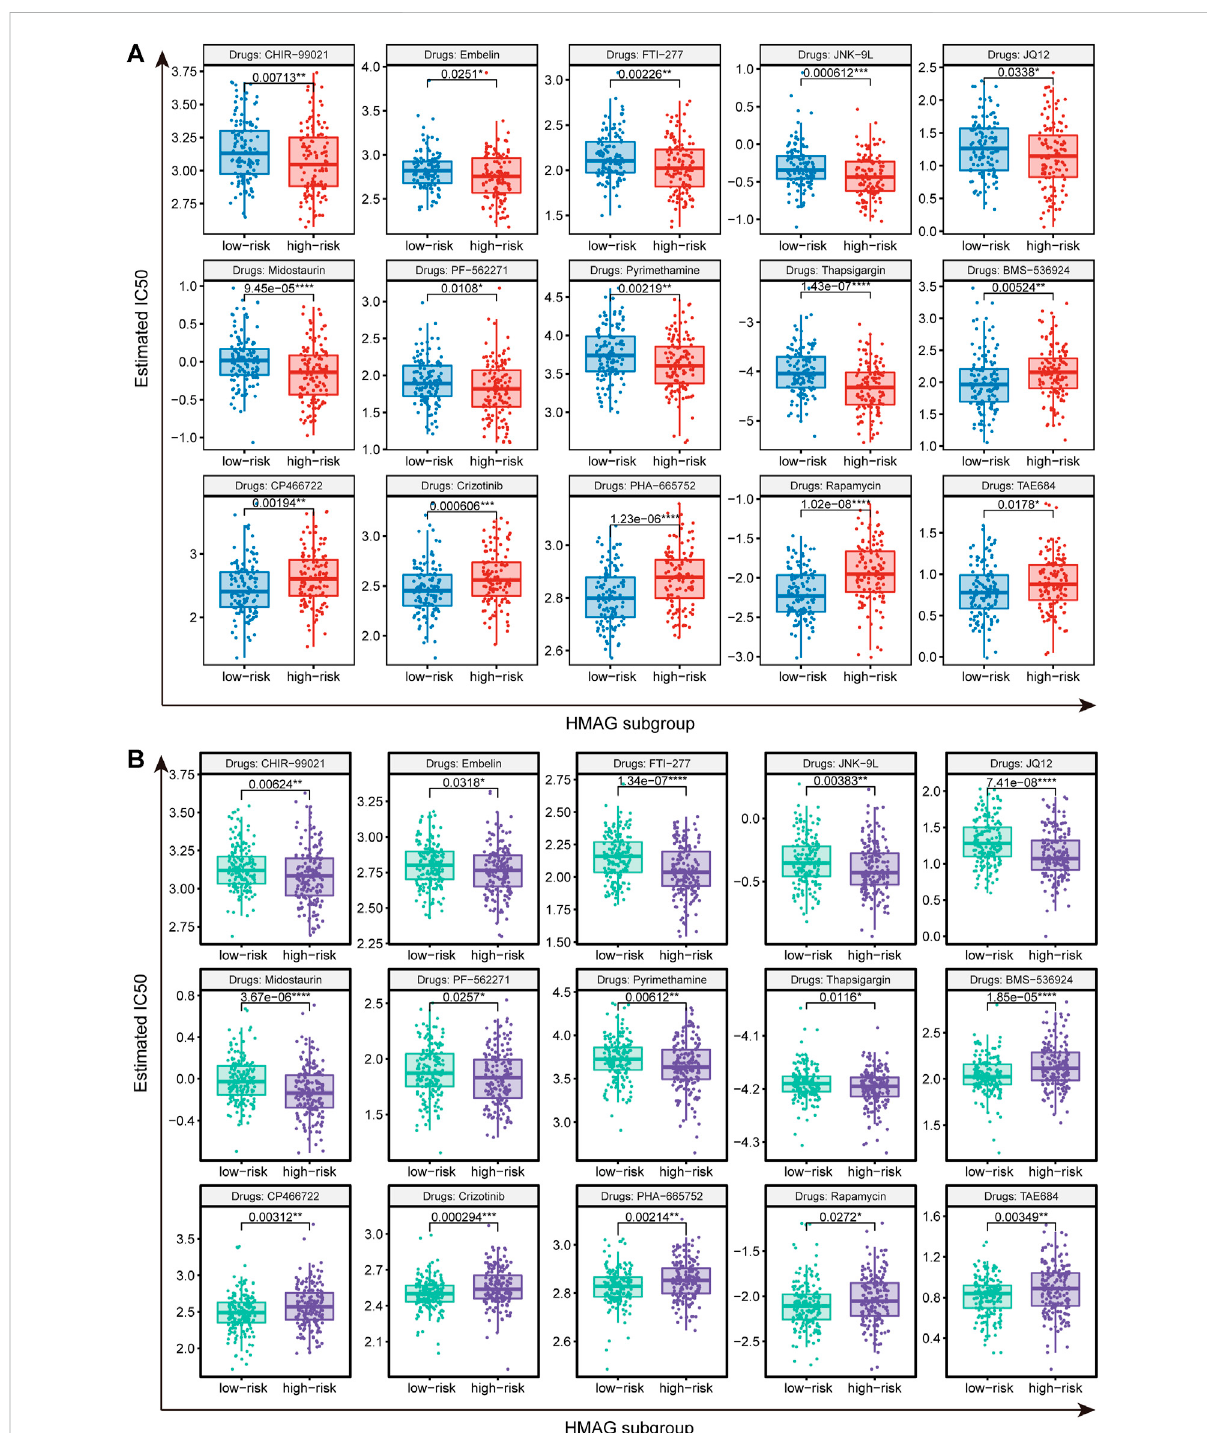
FIGURE 7 Prediction of therapeutic drugs for the HMAG low- and high-risk groups. (A) Potential therapeutic chemo drugs identi fi ed in TCGA-CESC cohort and (B) potential therapeutic chemo drugs validated in the GEO